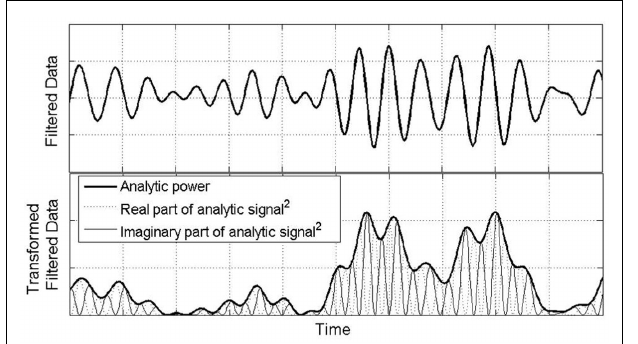
FIGURE 2 | Relationship of analytic power to time series.